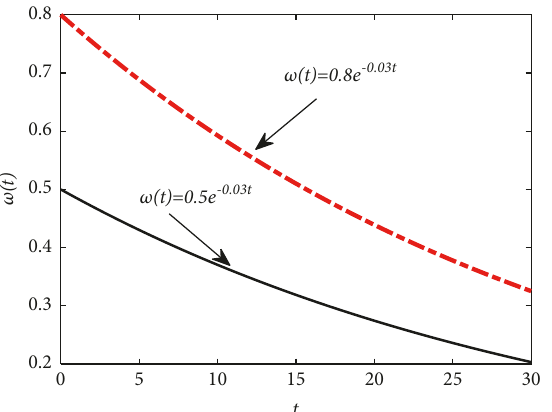
Figure 2: The effect of the deterioration rate on fashion level.